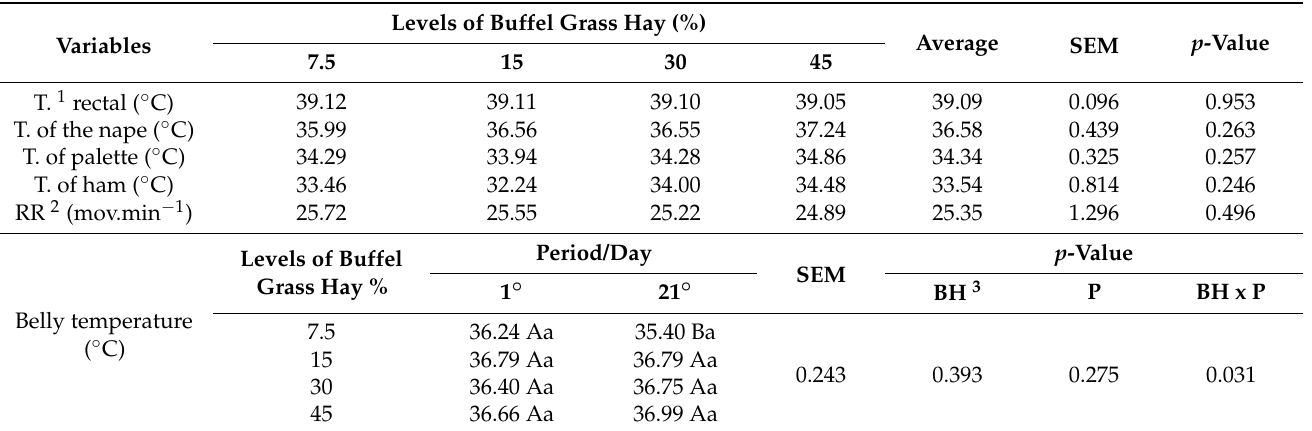
Table 5. Isolated effects for physiological parameters and interaction effect for belly temperature of sheep fed levels of buffel grass hay and cactus